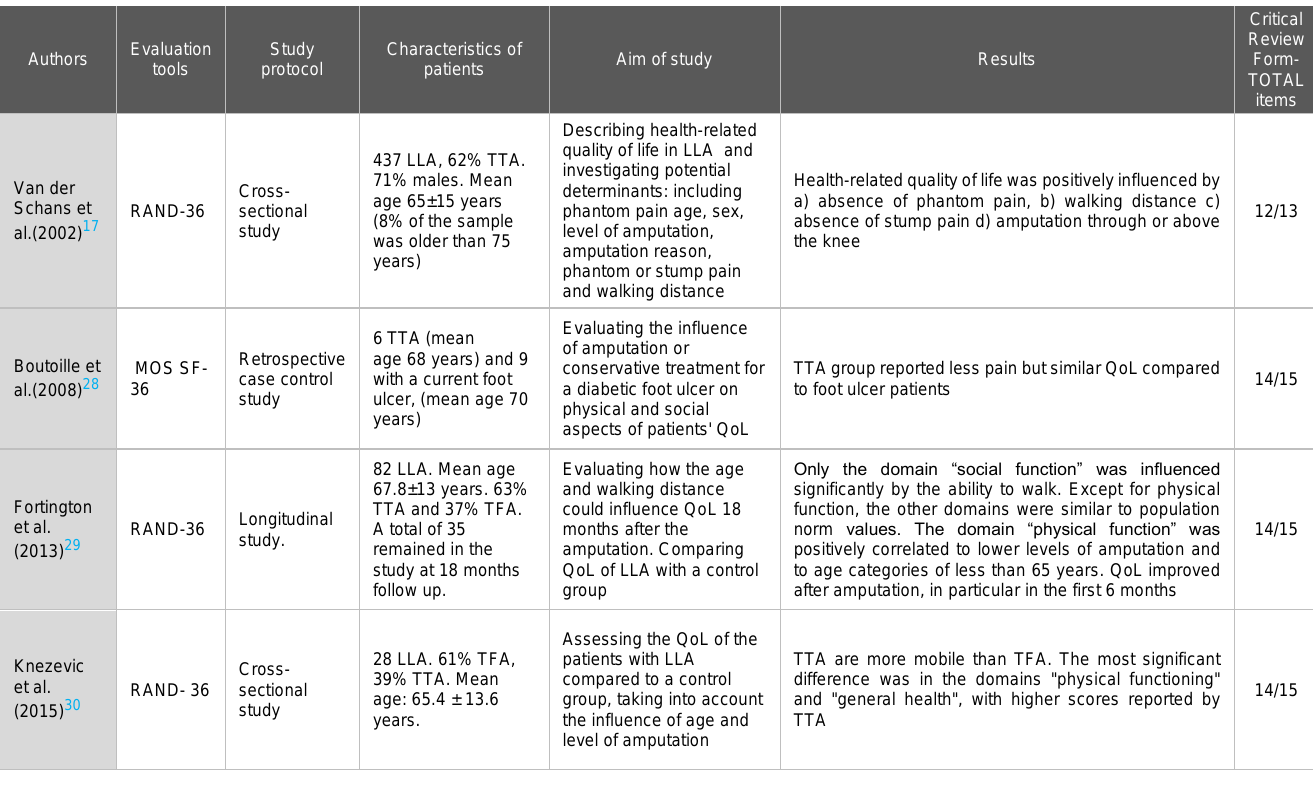
Table 2: Overview of studies reporting HS data.